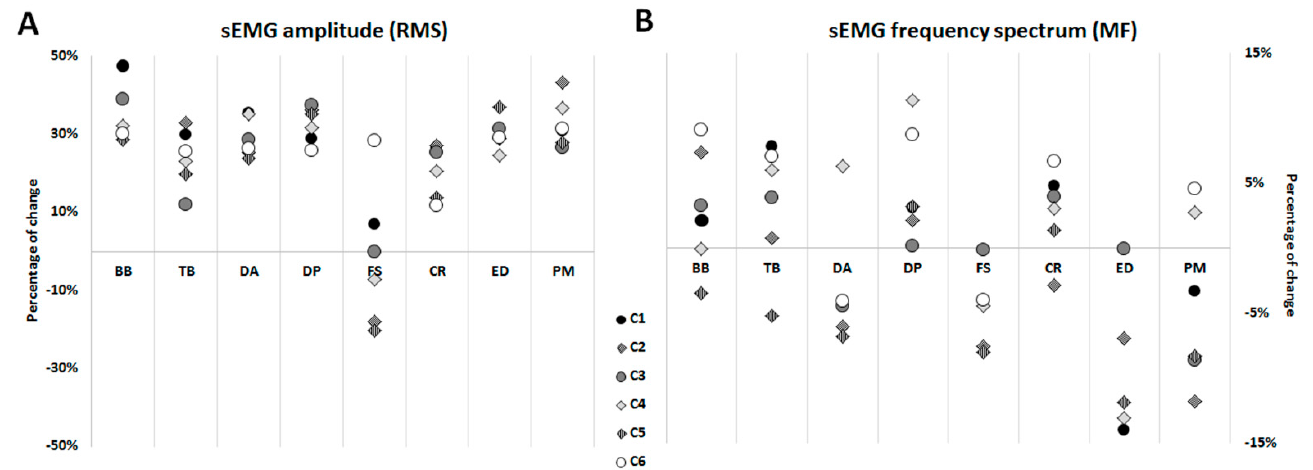
Figure 3. Averaged percentage of change in muscle activity between the first and the last lap of the three rounds, for each curve. ( A ): sEMG amplitude (RMS); ( B ): sEMG frequency(MF). Muscles are: biceps brachii (BB), triceps brachii (TB), anterior and posterior part of the deltoid (DA and DP respectively), flexor digitorum superficialis (FS), extensor carpi radialis (CR), extensor digitorum communis (ED), and pectoralis major (PM).